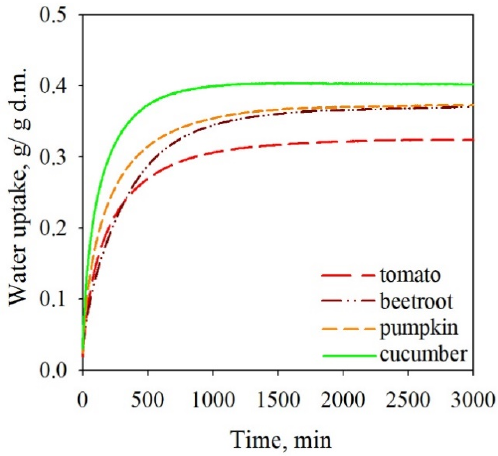
Figure 6. Kinetics of water sorption of freeze-dried soups at a w =